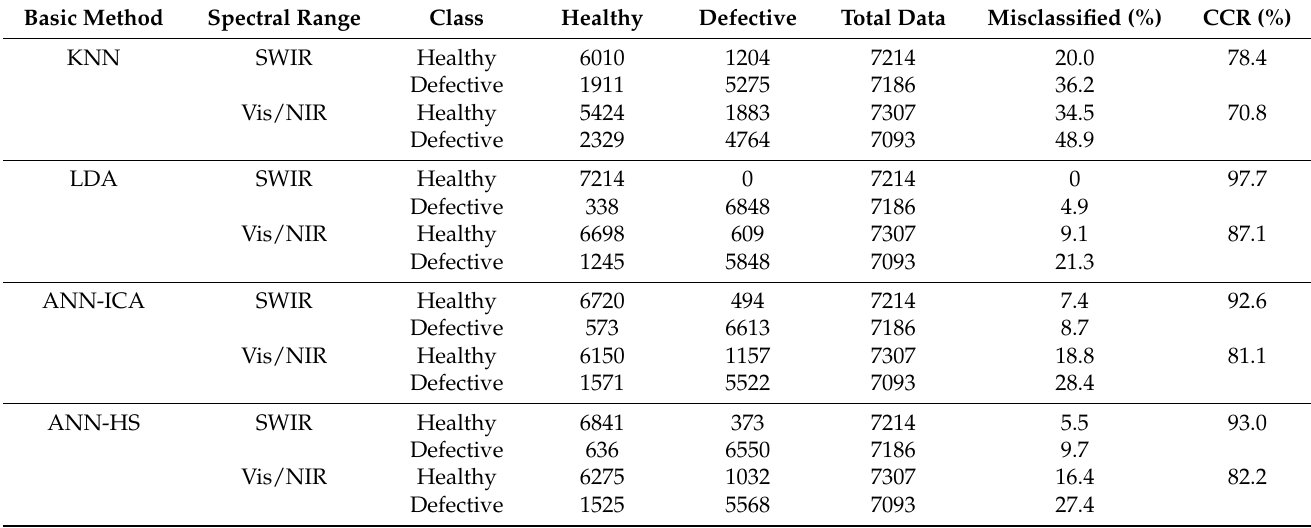
Table 5. Evaluation of the performance of the four basic classifiers using the confusion matrix, the error rate per class, and the CCR after 200 train/test iterations.